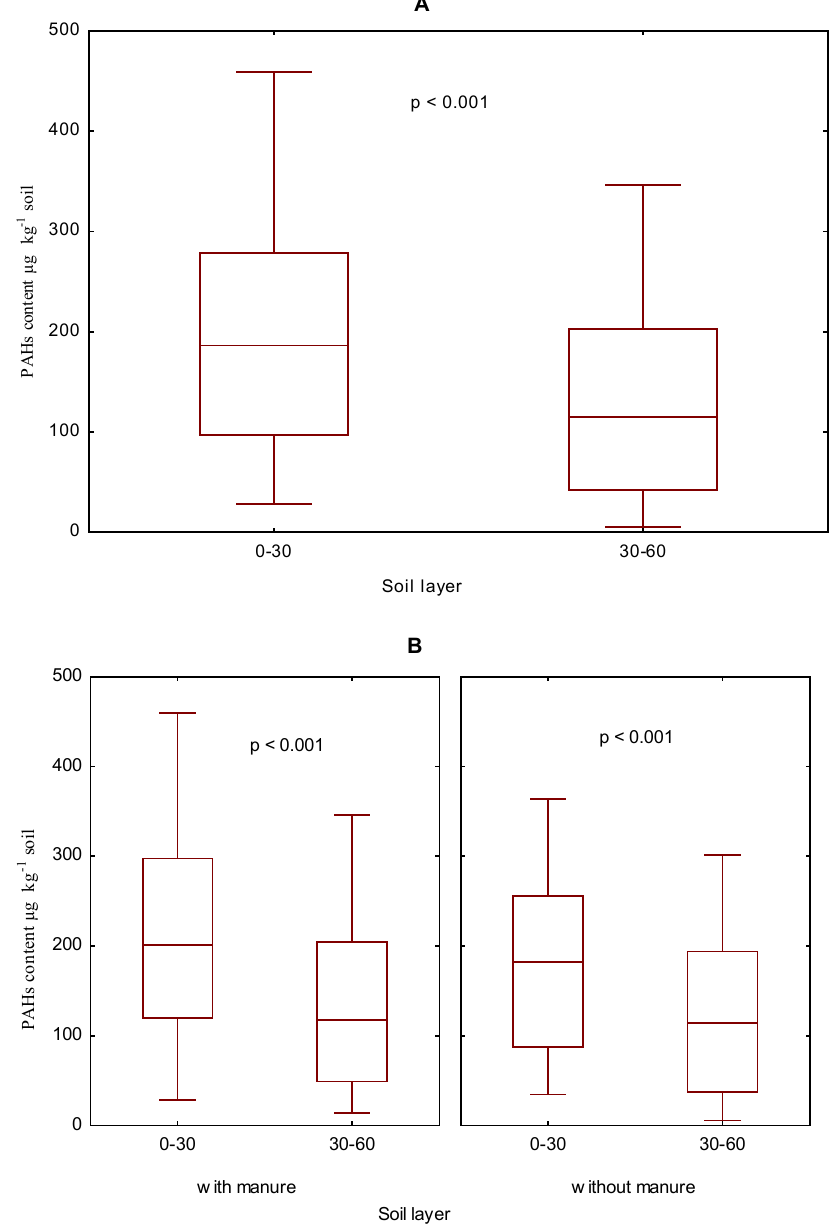
Figure 2. The content of the sum (16) of PAHs in the soil in the years 2006–2009 depending on the soil layer ( A ). The 030 cm and 30–60 cm and manure fertilization ( B ) in µ g kg − 1 . No significant differences were observed in the content of the sum (16) of PAHs between the two soil layers: 0–30 and 30–60 cm deep, in soil without natural fertilizer, fertilized with the smallest doses of nitrogen and potassium or in limed soil (Figure 3). T results clearly demonstrated that a higher content of PAHs, with differences confirmed statistically as significant or insignificant ones, appeared in the soil fertilized with